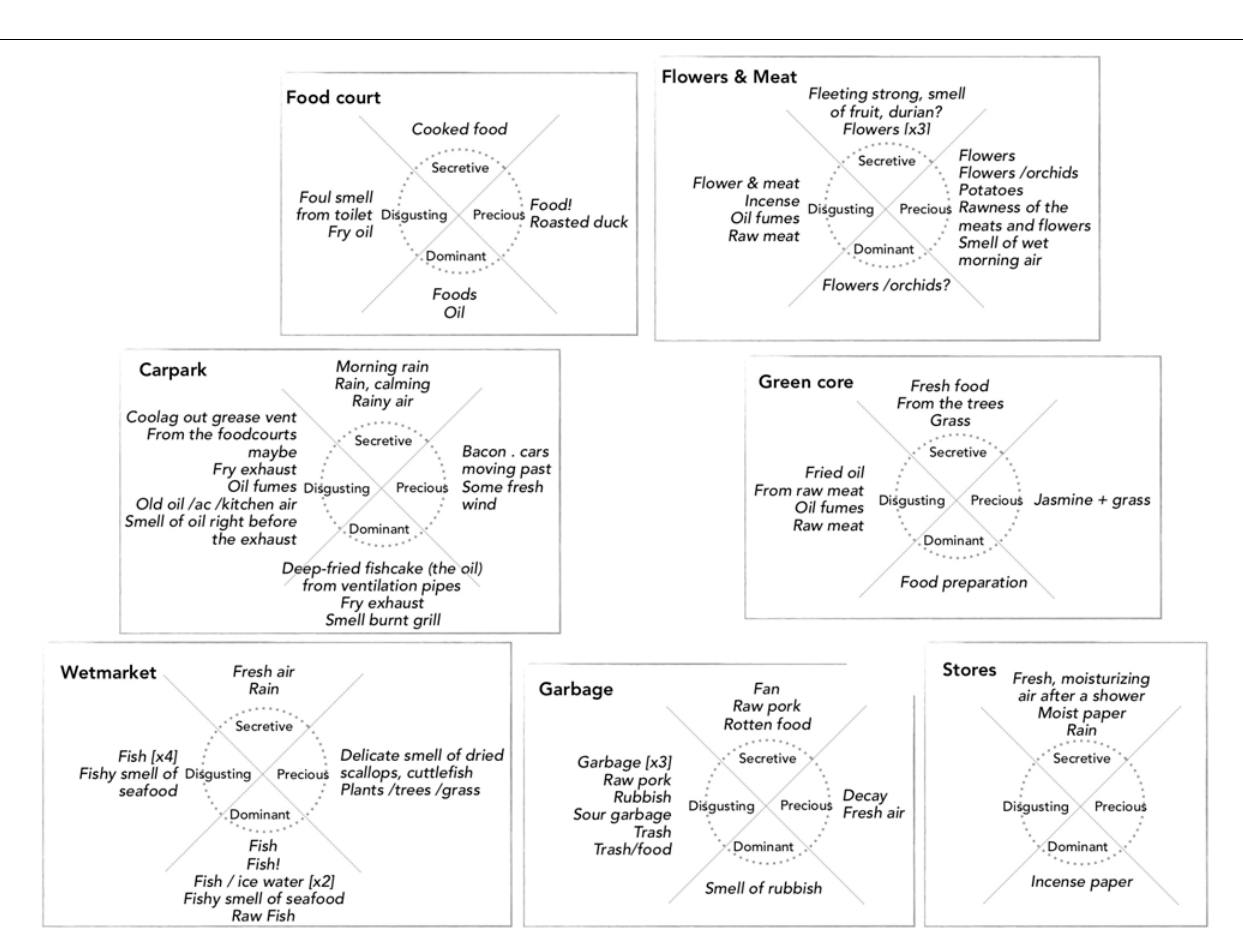
Frontiers in Psychology |